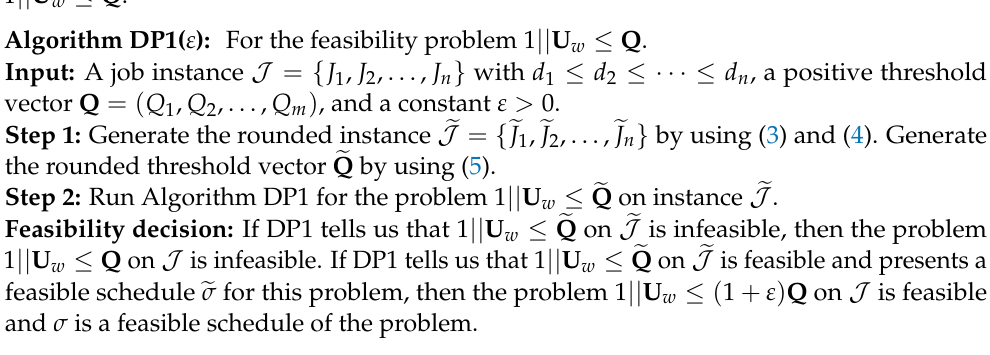
Algorithm DP1( ε ): For the feasibility problem 1 || U w ≤ Q